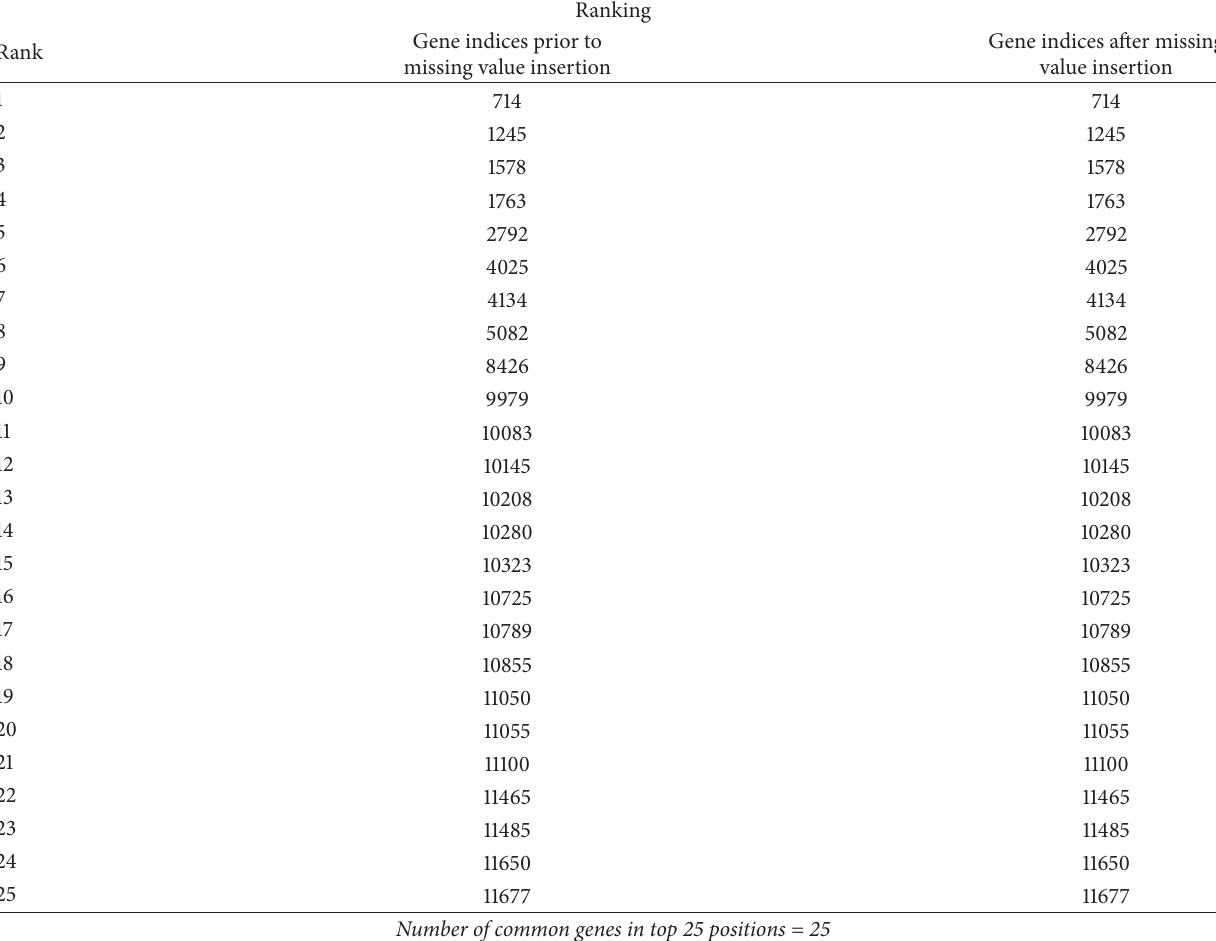
Table 7: Top 25 gene indices before and after estimation for GDS4382.